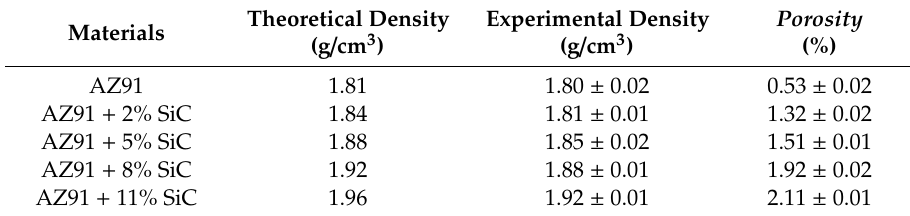
Table 2. Density and porosity measurements of AZ91 alloy and its composite (AZ91 / SiC).